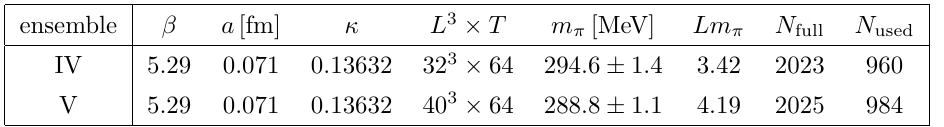
Table 1 . Details of the gauge ensembles used in this analysis. N full is the total number of available gauge configurations, and N used is the number of configurations used in our simulations. More detail can be found in [86,